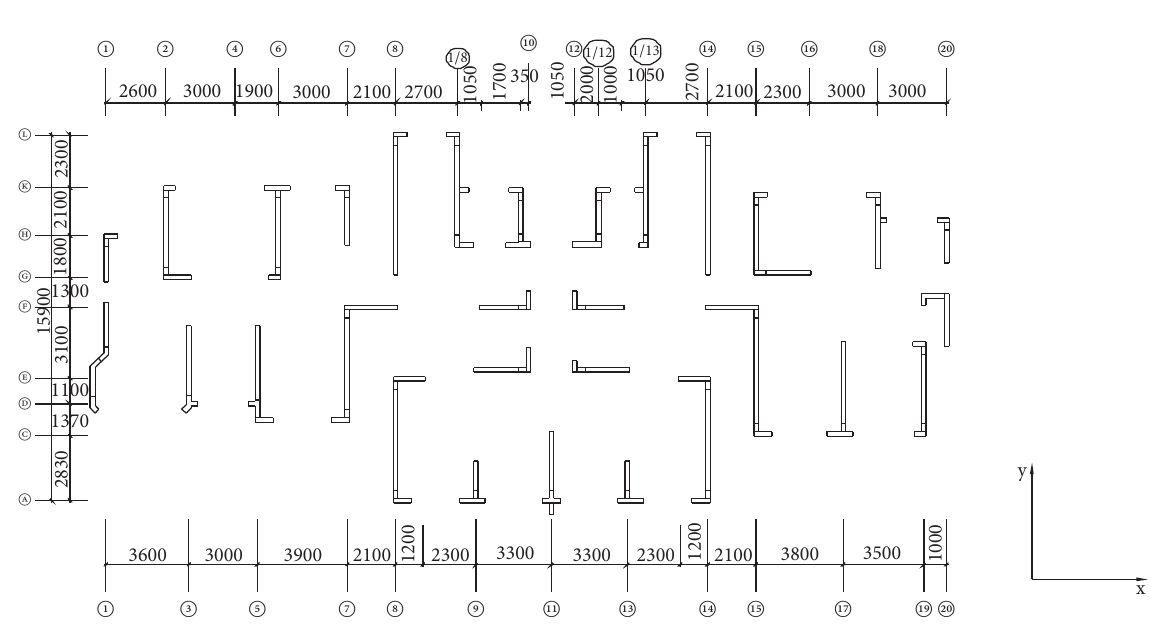
Figure 12: Configuration of RHC shear wall.